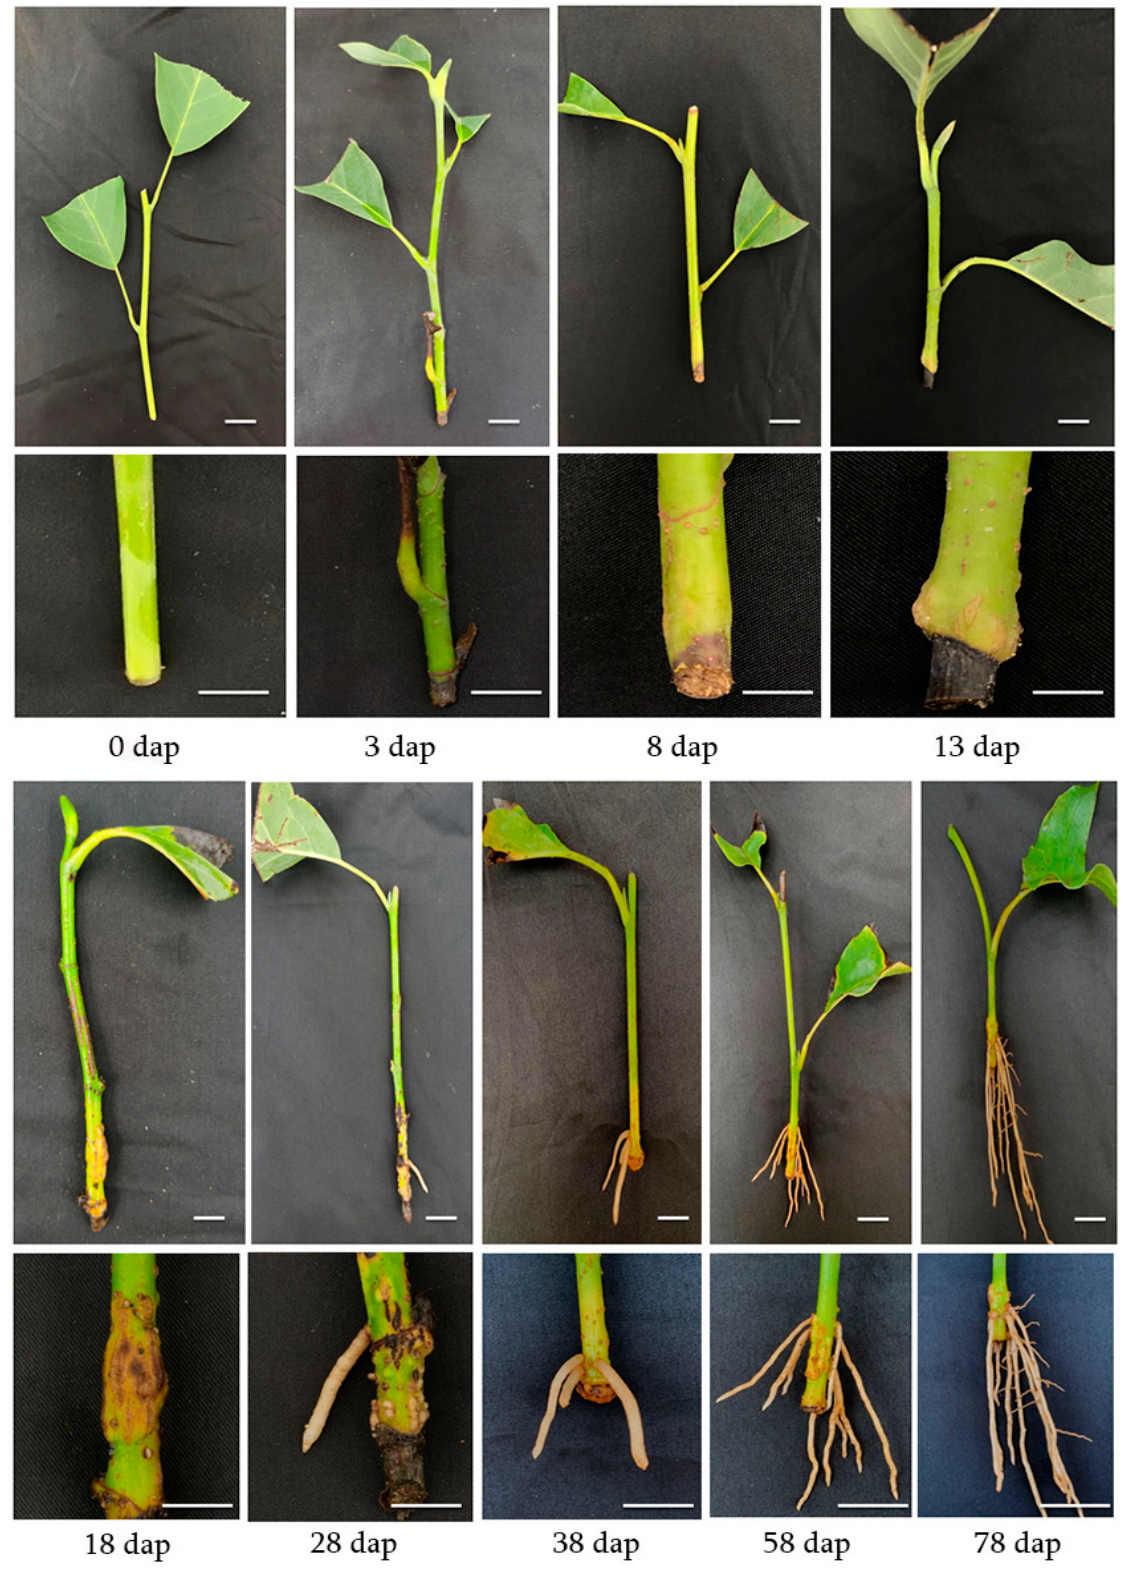
Figure 4. Morphological changes of cuttings treated with NAA:IBA (2:1) on day 0, 3, 8, 13, 18, 28, 38, 58, and 78 after planting. dap means days after planting. Bars: 1 cm.